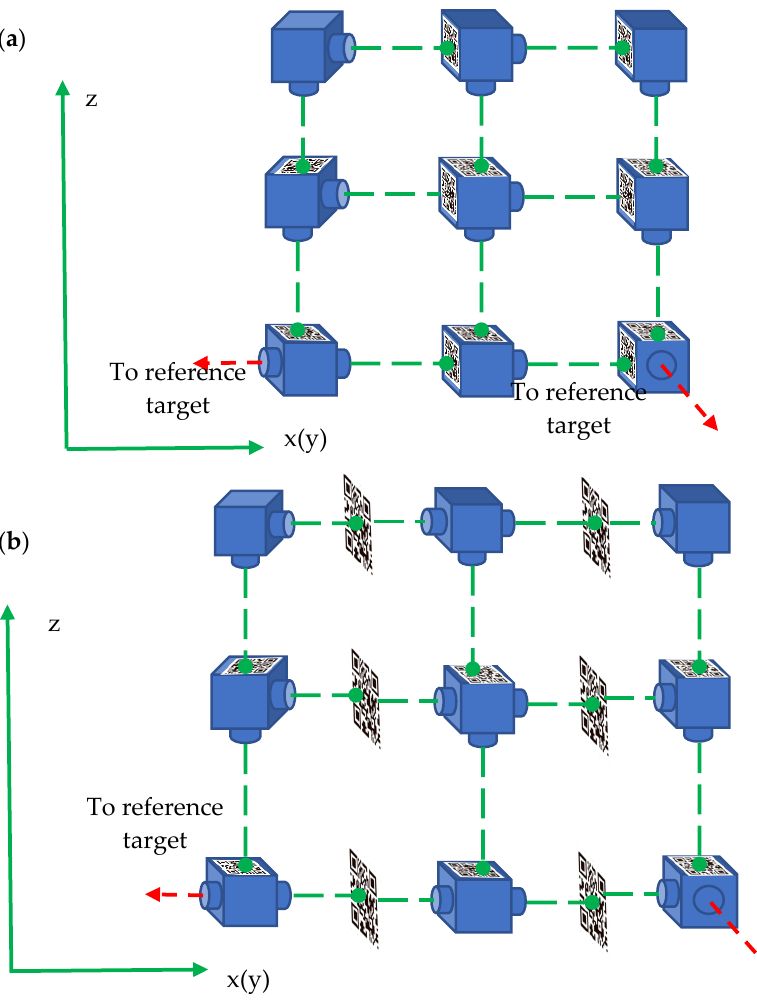
Figure 6. VOS installation schemes: ( a ) the scheme with sensor-to-sensor observations; ( b ) the scheme with sensor – target – sensor.